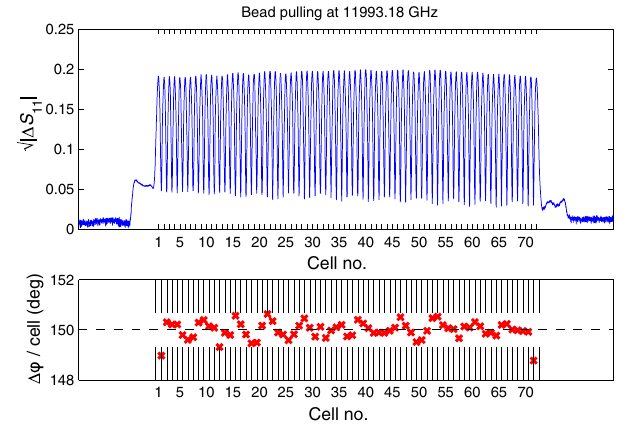
FIG. 21. Field amplitude (top) and phase advance (bottom) measurements of the X-band structure using the bead-pull method, after tuning. Measurements and tuning were carried out at CERN